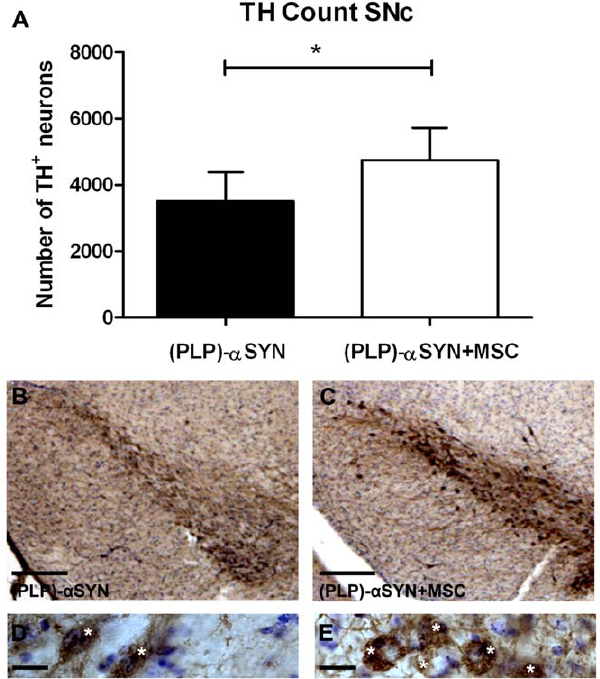
Figure 3. Neuroprotection of dopaminergic neurons in SNc after MSC treatment of (PLP)- a SYN mice. Quantification of TH- immunoreactive neurons in the SNc demonstrating a significant survival of TH + neurons (p=0.036) in animals with MSC treatment compared to controls, four weeks after i.v. MSC transplantation ( A ). Low magnifica- tion of TH immunohistochemistry, counterstained with Nissl in (PLP)- a YN ( B ) and (PLP)- a SYN + MSC treated animals ( C ). Scale bar ( A , B ) represent 300 m m. High magnification of TH neurons in SNc of Tg ( D ) and Tg + MSC treated animals ( E ). Scale bar ( D , E ) represent 20 m m. Cell counts were analysed by unpaired Student’s t-test and the level of significance was set at p , 0.05 (* p , 0.05). Data are presented as means 6 SEM. (PLP)- a SYN (n=6); (PLP)- a SYN + MSC (n=7); Asterisk in D and E indicate TH + neurons.